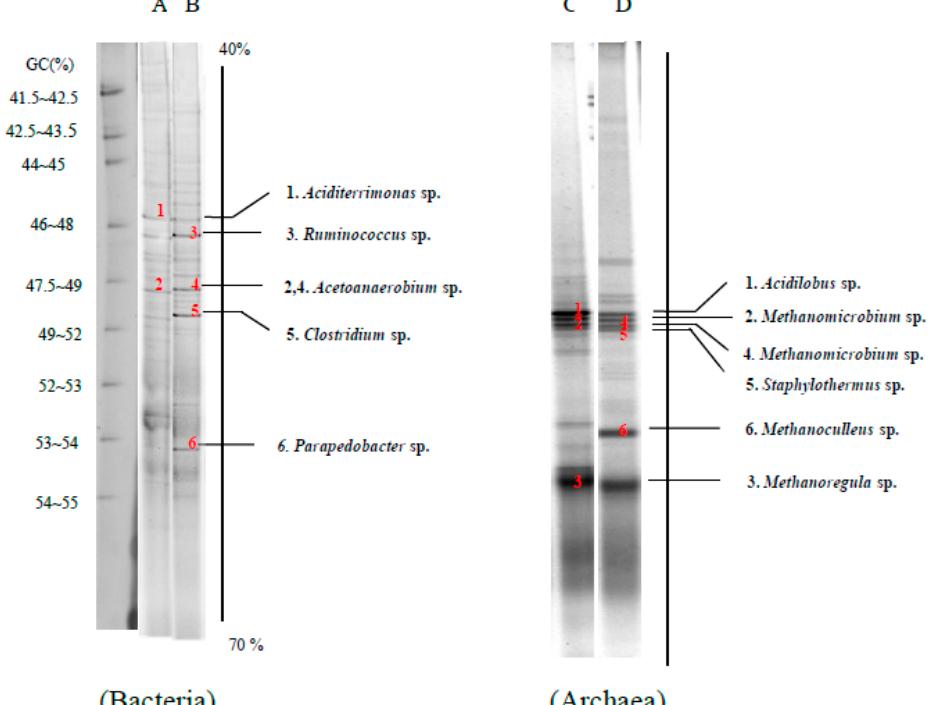
Figure 2. Polymerase chairn reaction and denautring gradeint gel electrophoresis (PCR-DGGE) profiles of bacteria and archaea at the end of a methane production from co-digestion of grass with cow dung and silage with cow dung by self-fermentation at the optimal mixing ratio of 1:1. Lanes A and B: bacteria community from co-digestion of grass with cow dung and silage with cow dung, respectively. Lanes C and D: archaea community from co-digestion of grass with cow dung and silage with cow dung, respectively.